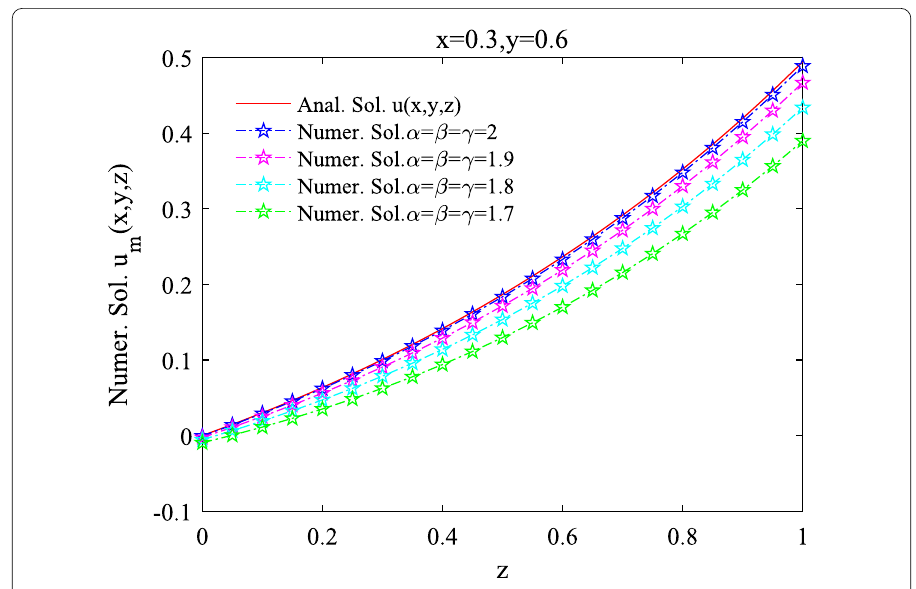
Figure 8 The numerical solutions with different fractional order α , β , γ when m = 32 for Example